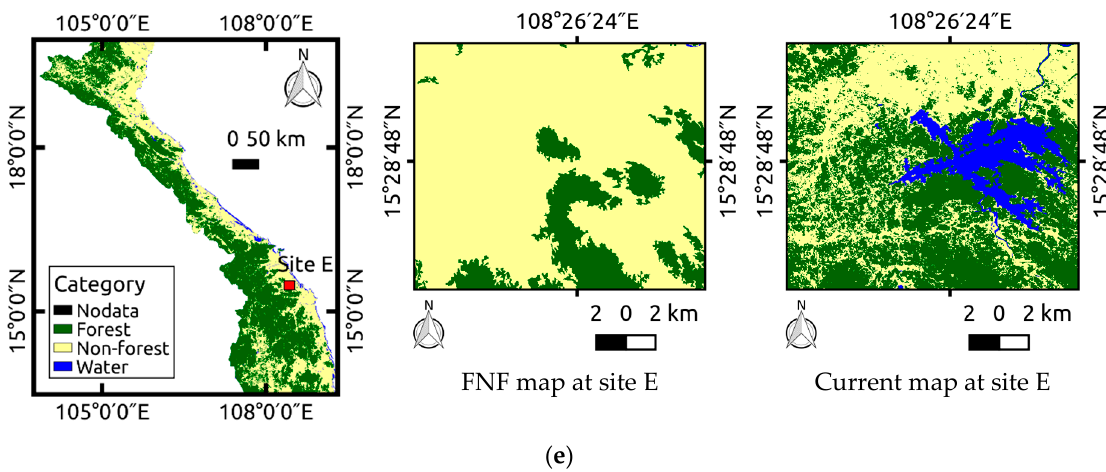
Figure 5. A comparison of current maps and the existing global land cover maps over Central Vietnam, using visual interpretations: ( a ) Climate change initiative (CCI) 300-m land cover V2 for the year 2015 released by ESA; ( b ) GlobeLand30 map for the year 2015 published by the National Geomatics Center of China; ( c ) MCD1Q1 0.5 km MODIS-based global land cover climatology for the years 2001–2010 published by the USGS; ( d ) Global PALSAR-2 25-m Forest/Non-forest map for the year 2007, and ( e ) Global PALSAR 25-m Forest/Non-forest map for the year 2007 from JAXA.